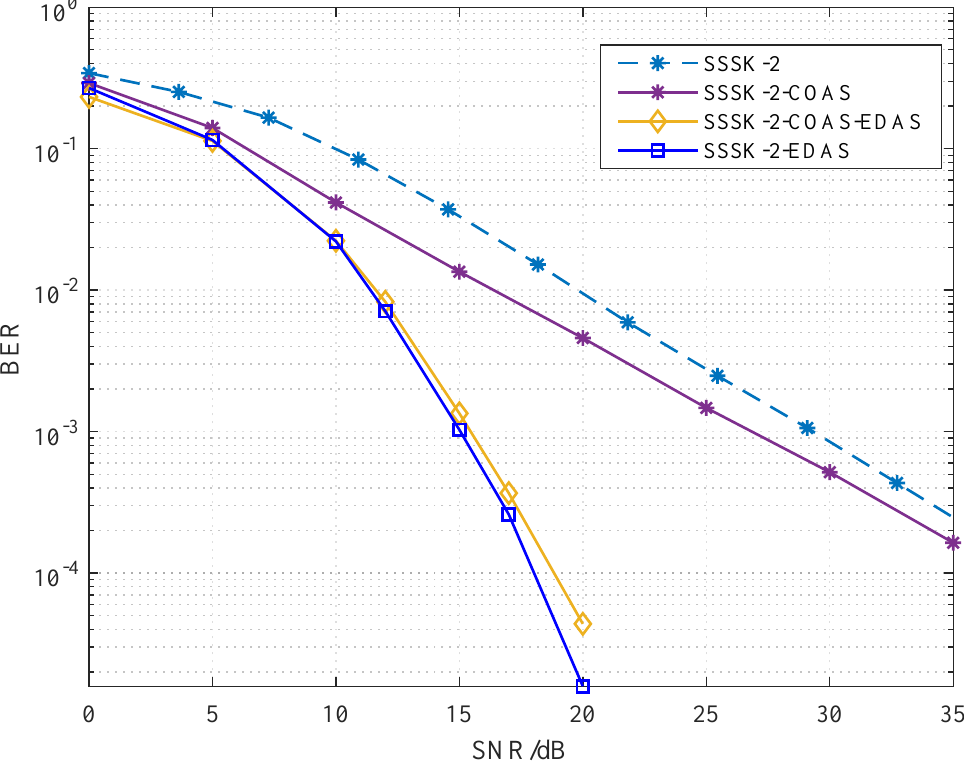
Figure 5. BER performance of SSSK with N t = 8, q = 4, N r = 1, q t = 6 and L = 2